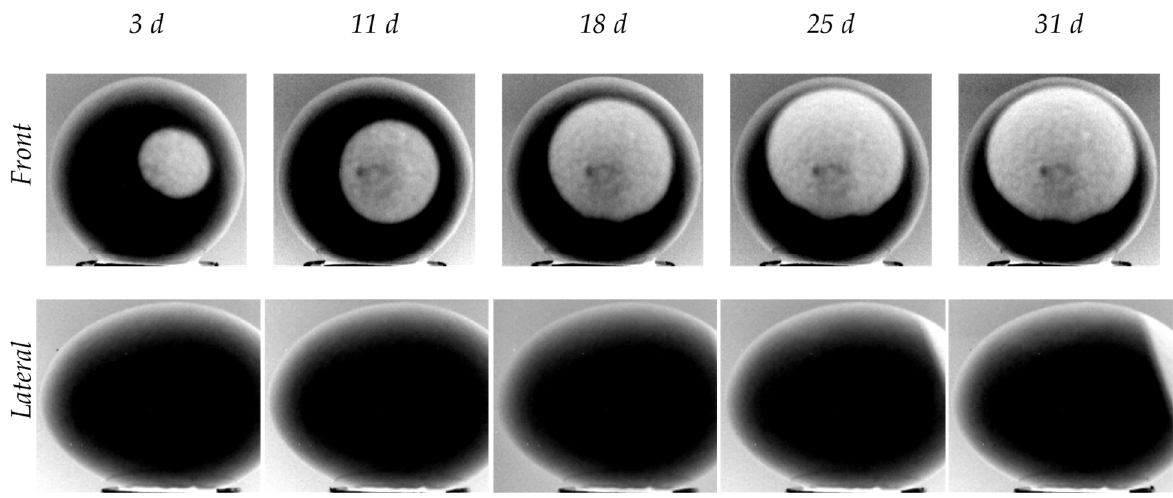
Figure 5. Grayscale phase IR images of egg XL#7 recorded on different days. First row: front view (dull pole). Second row: lateral view.